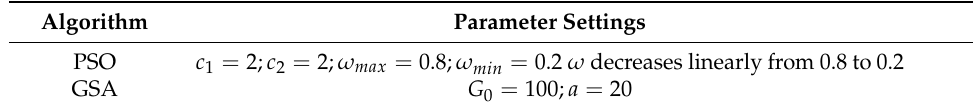
Table 1. Parameter settings for each algorithm in the test